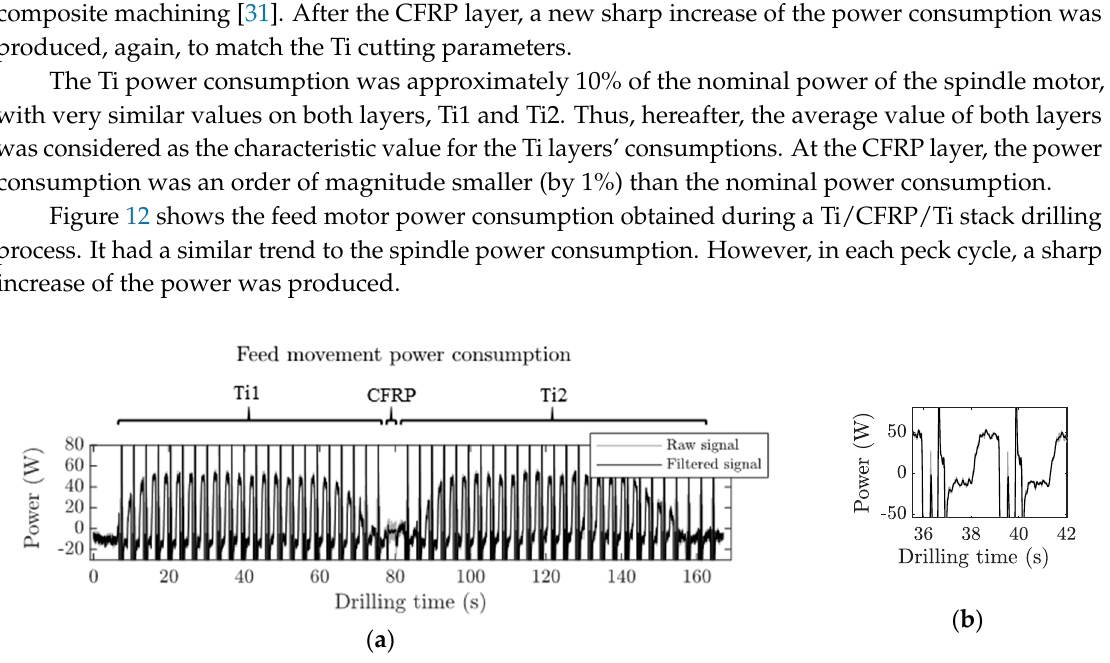
Figure 12. Feed movement power consumption signal of the 40th hole with the higher lubrication level (15 mL/h) recorded during the Ti/CFRP/Ti drilling. ( a ) The complete signal of the drilling process. ( b ) A detailed view of a peck drilling cycle on the first Ti layer.